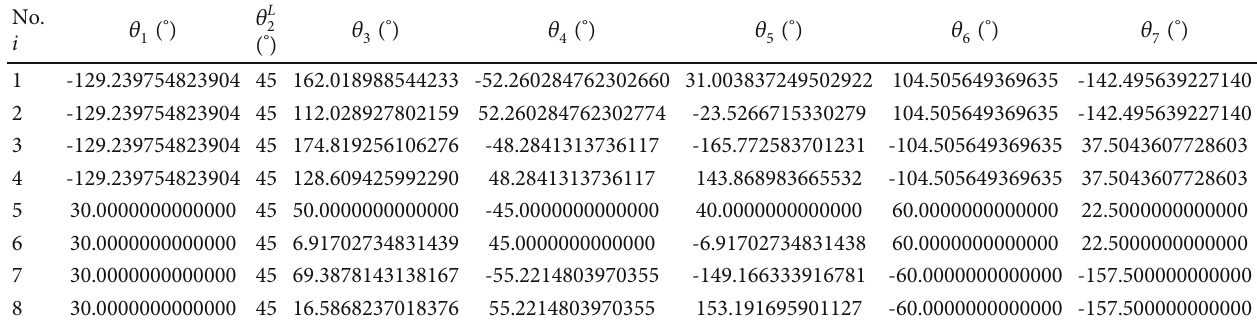
Table 3: The eight sets of solutions for locking the second